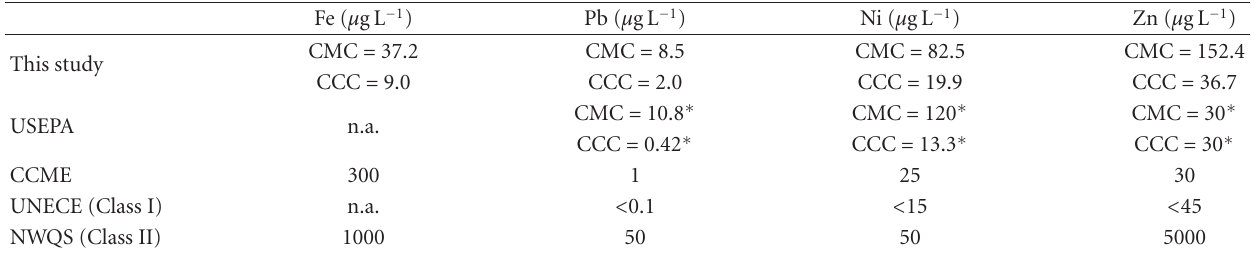
Table 3: Comparison criteria of metal concentration in freshwater